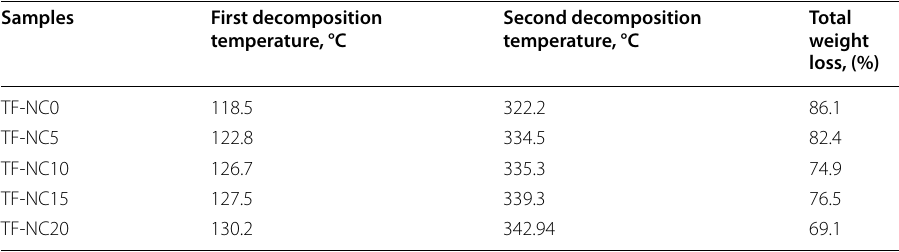
Table 4 Decomposition stages and percentage of weight loss for various compositions of polymer electrolytes (PMMA-LiTf-nanochitosan)